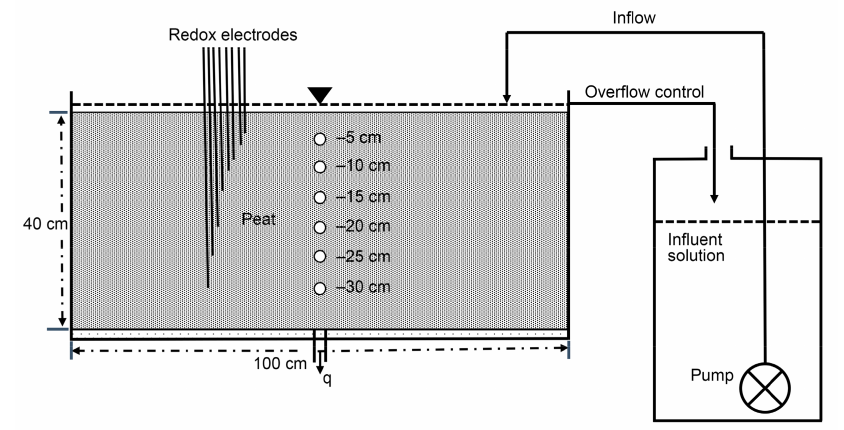
Figure 1. Schematic diagram of the mesocosm experimental set-up and illustration of water and gas sampling locations ( − 5, − 10, − 15, − 20, − 25, − 30 cm, and